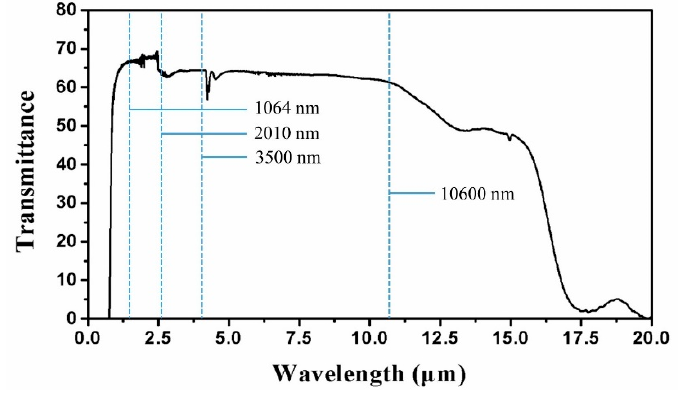
Figure 6. Measured transmittance of the ChG MLA.